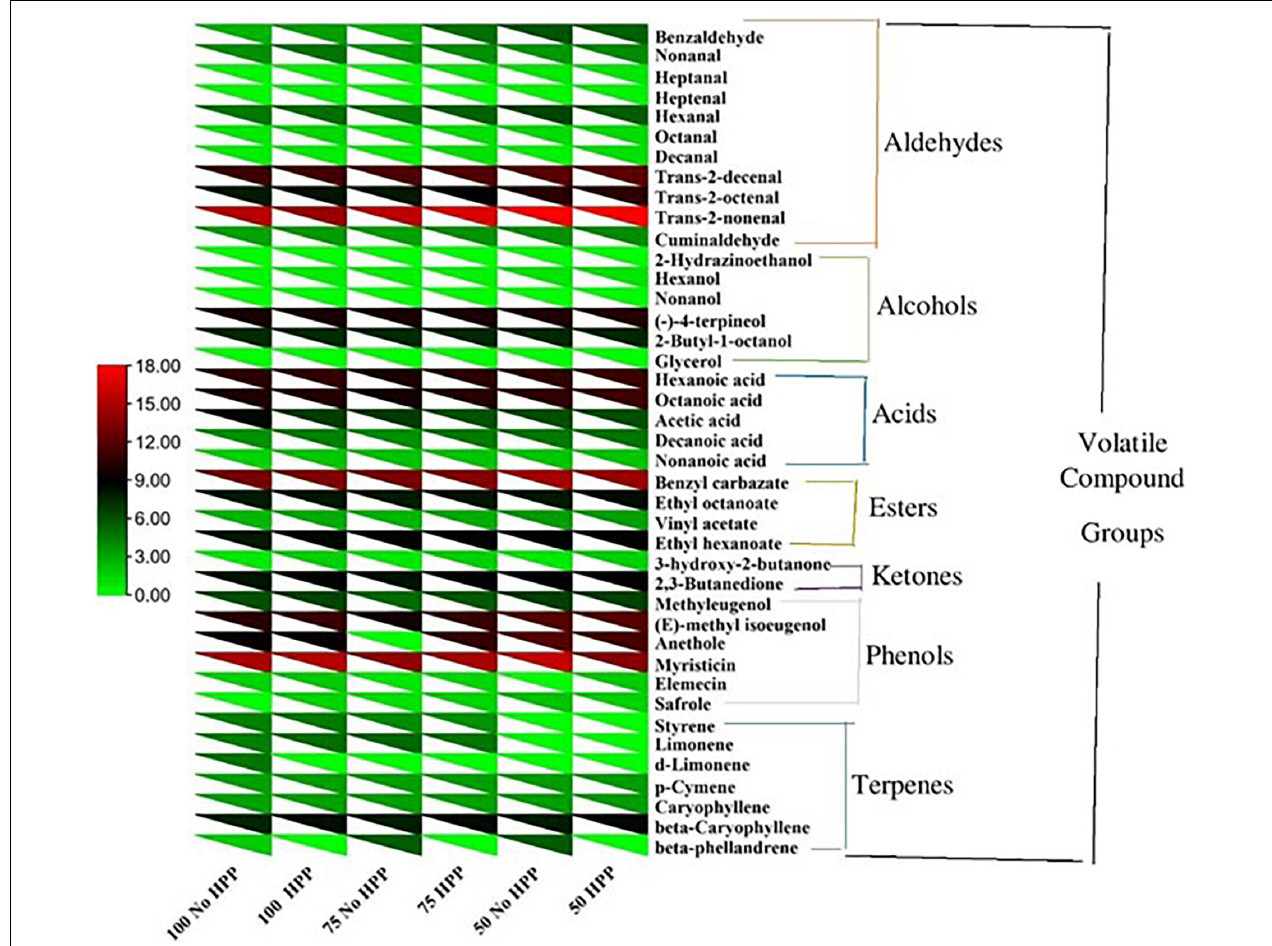
FIGURE 5 | Heat map of odor activity values (OAVs) of volatile compounds in sausage stored at 3 days. The color scale indicates the intensity of the OAV.